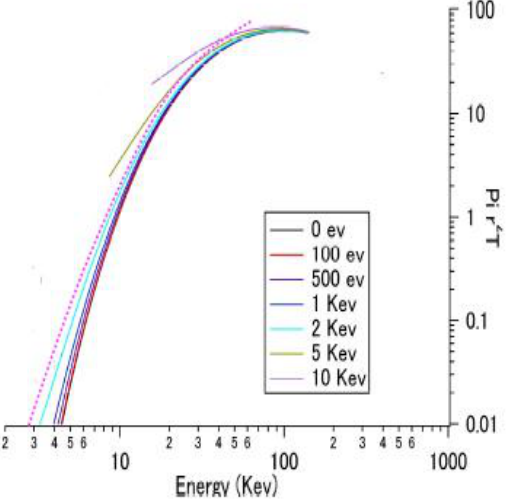
Figure 9. Natural nuclear potential without laser.